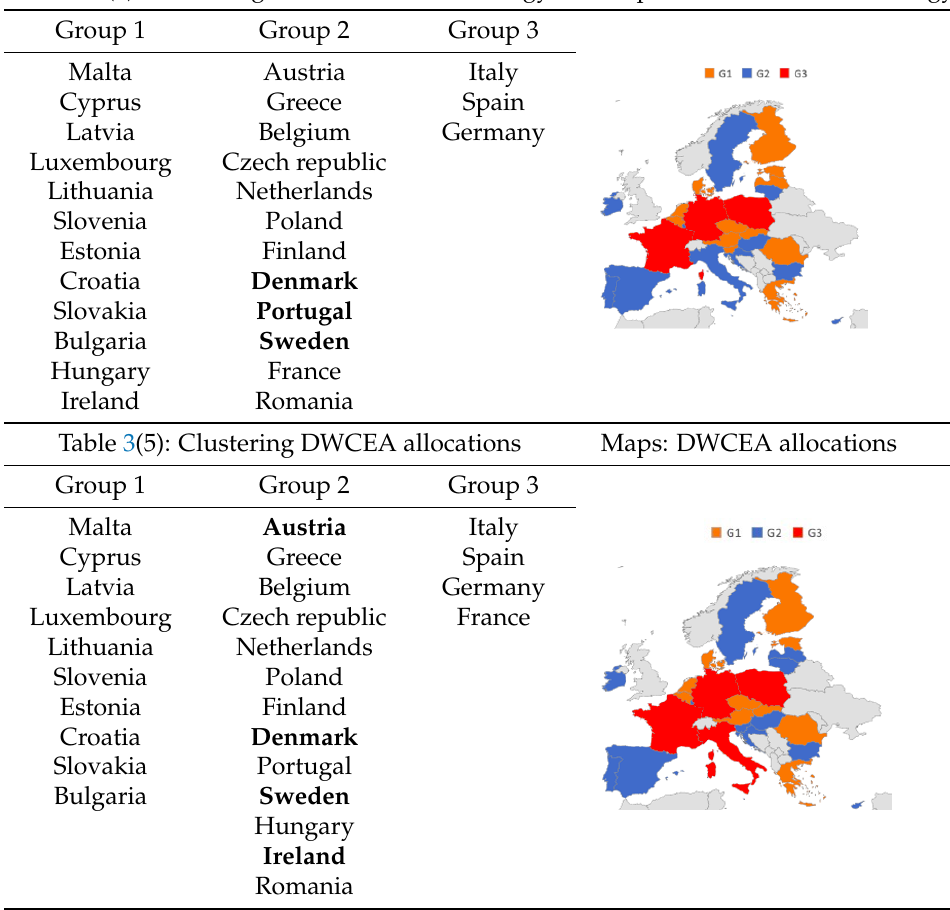
Table 3(5): Clustering DWCEA allocations Maps: DWCEA